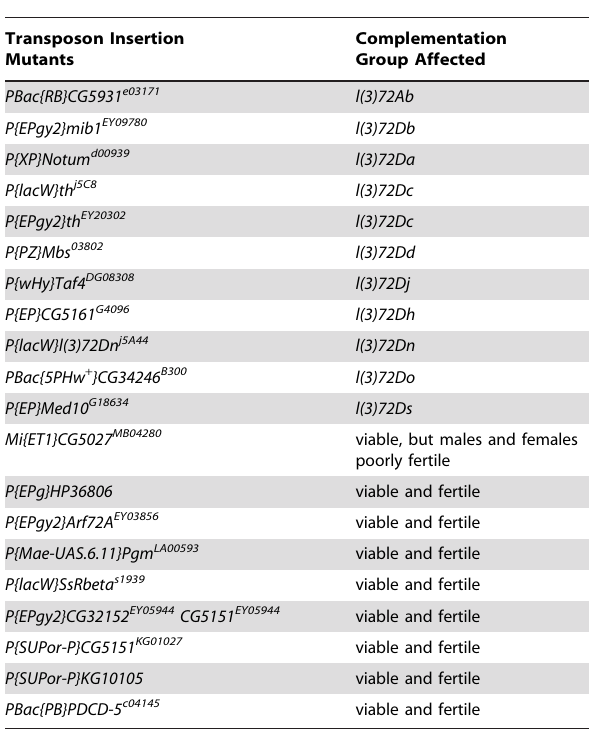
Table 2 . Transposon insertion mutants identified by the Drosophila Gene Disruption Project and maintained by the Bloomington Drosophila Stock